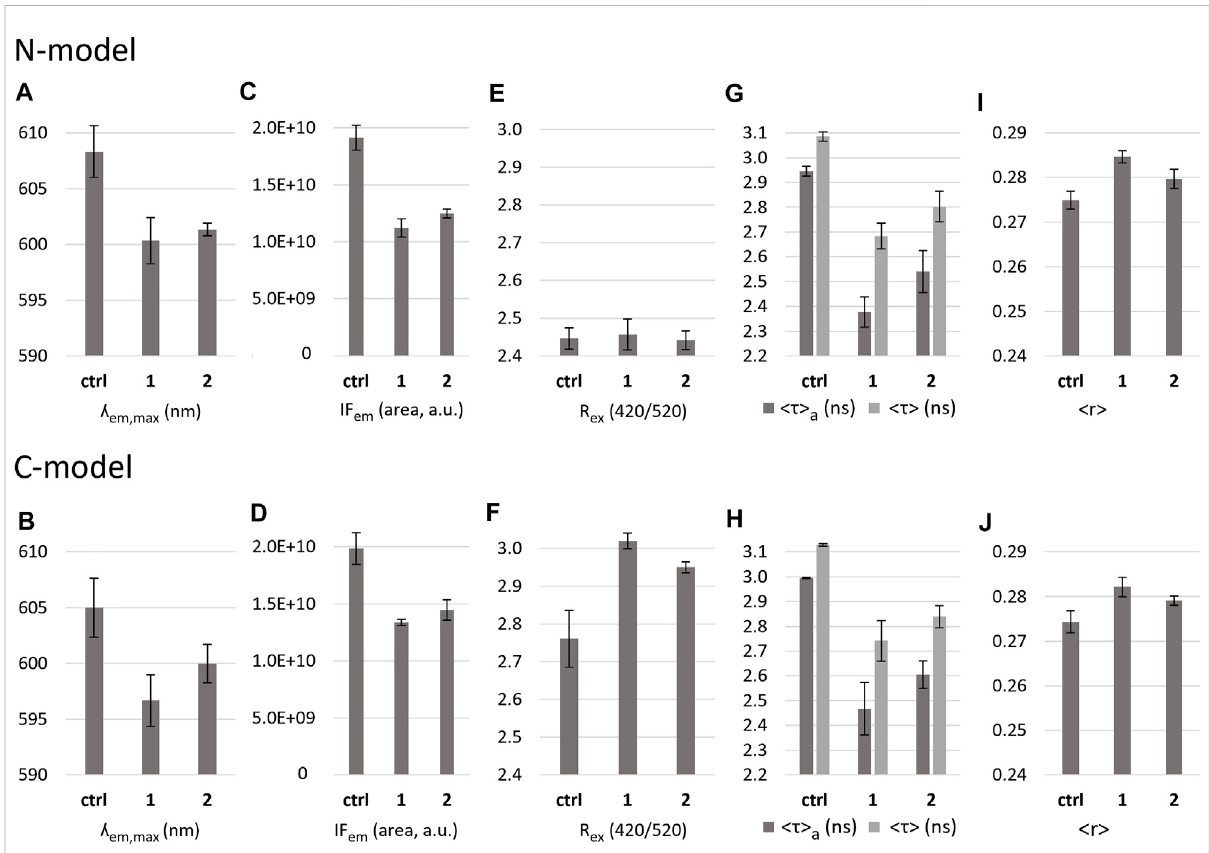
FIGURE 10 Effectofthecomplexeson N-model and C-model asreportedbydi-4-ANEPPS fl uorescenceproperties. (A,B) :maximumemissionwavelength ( ? em,max ); (C,D) : fl uorescenceintensitymeasuredastheareaoftheemissionspectrum(IF em ); (E,F) :averagedipolepotentialmeasuredastherationof intensity at 420 nm and 520 nm excitation (R ex (420/520)); (G,H) : average amplitude-weighted lifetimes < τ > a , and average intensity-weighted lifetimes < τ > , and (I,J) : fl uorescence anisotropy < r > of the probe in the absence and the presence of complexes 1 and 2 in buffer